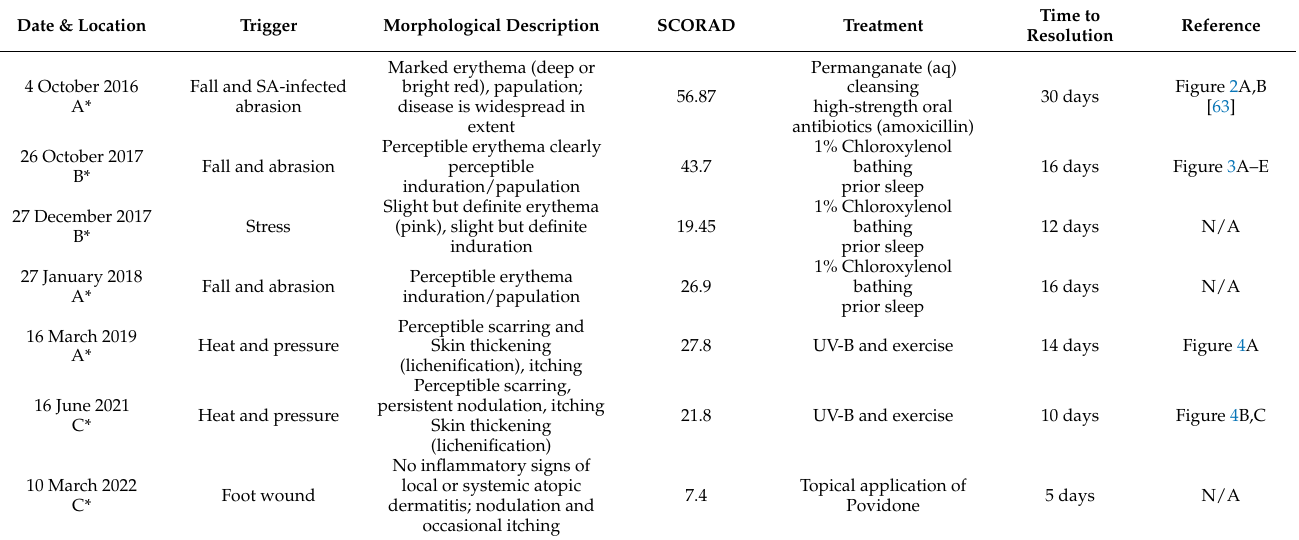
Table 2. Changes in the SCORAD value of patient X in response to various